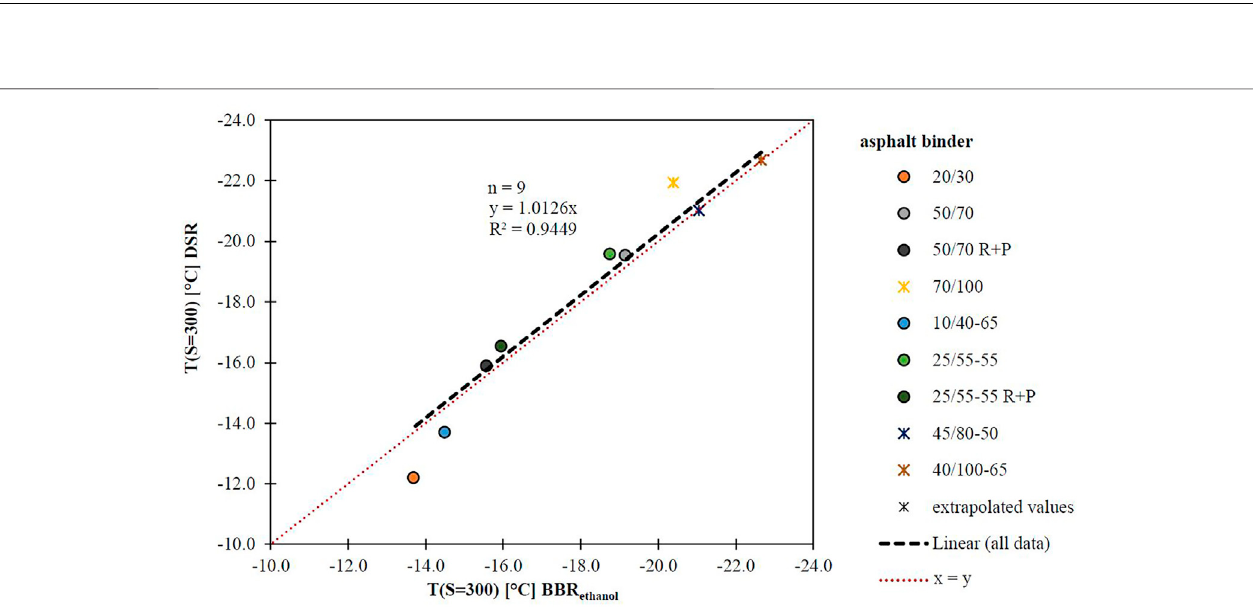
FIGURE 11 | Correlating characteristic temperatures T ( S = 300) obtained from BBR tests and DSR tests.